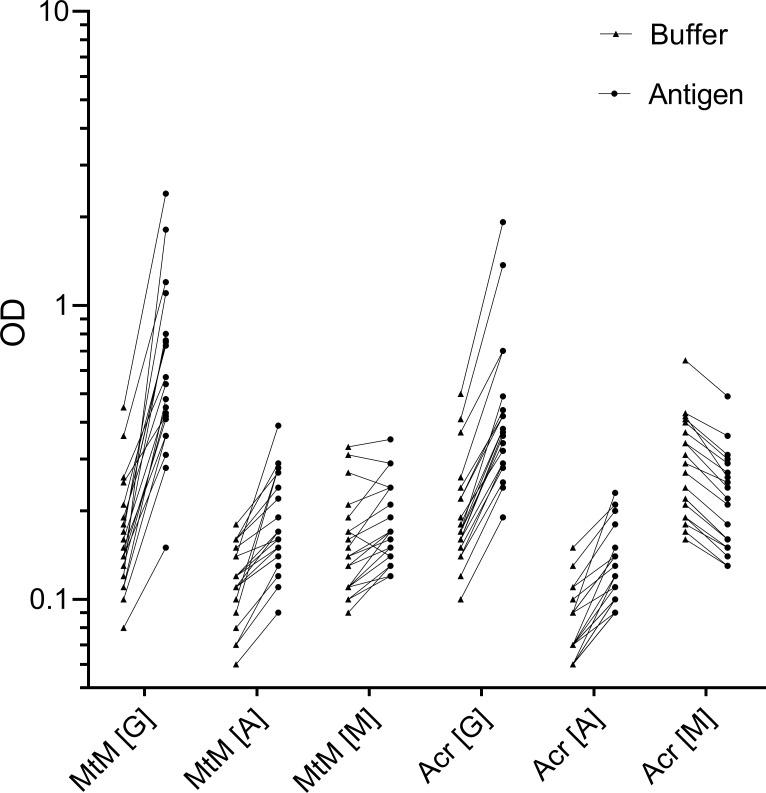
Non-specific binding of serum immunoglobulins to ELISA plates blocked with milk.Binding (OD) of IgG, IgA and IgM to ELISA plate-wells coated with buffer (coating buffer) or antigen (MtM or Acr) are shown for 20 sera. Individual pairs of values are connected by solid lines.